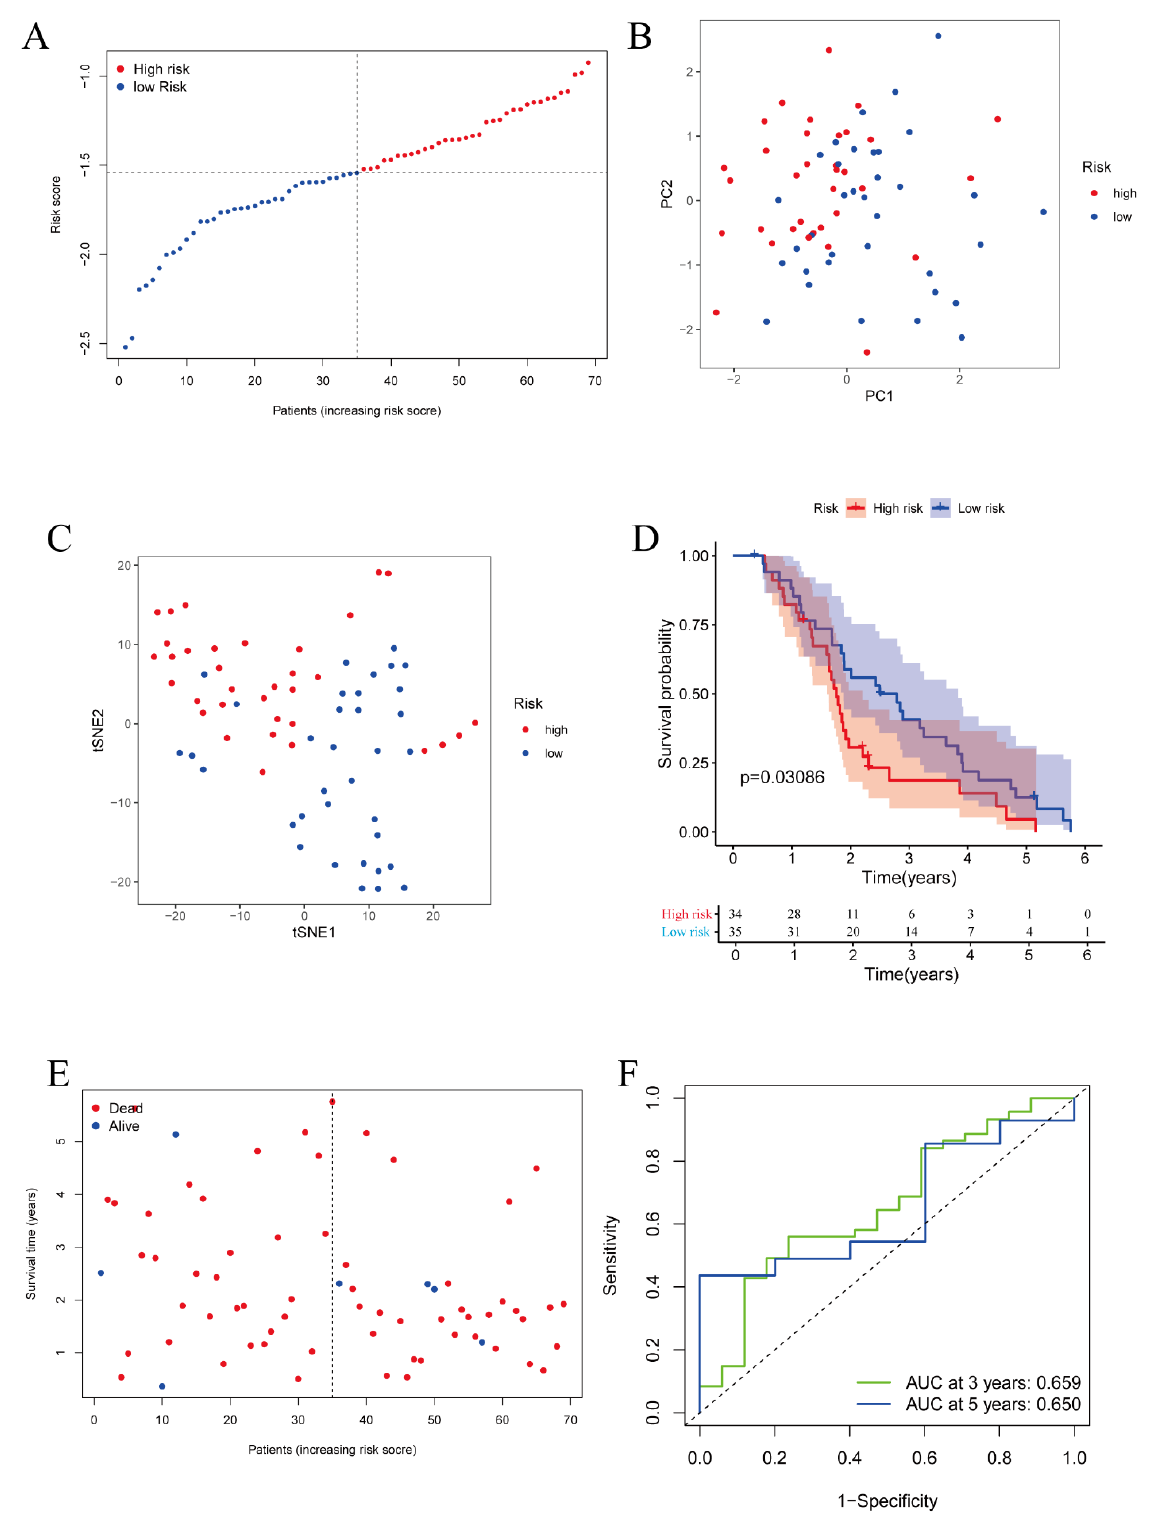
Figure 4. Validation of the prognostic signature in the ICGC cohort. ( A ) Distribution of the risk score in the ICGC cohort. ( B ) PCA plot of the ICGC cohort by 5 genes. ( C ) t-SNE analysis in the ICGC cohort by 5 genes. ( D ) Kaplan – Meier survival curve for OS of ovarian cancer in the ICGC cohort. ( E ) Distribution of survival status and risk score of each patient. ( F ) ROC curve demonstrating the predictive efficiency of the 5-gene prognostic signature in the ICGC